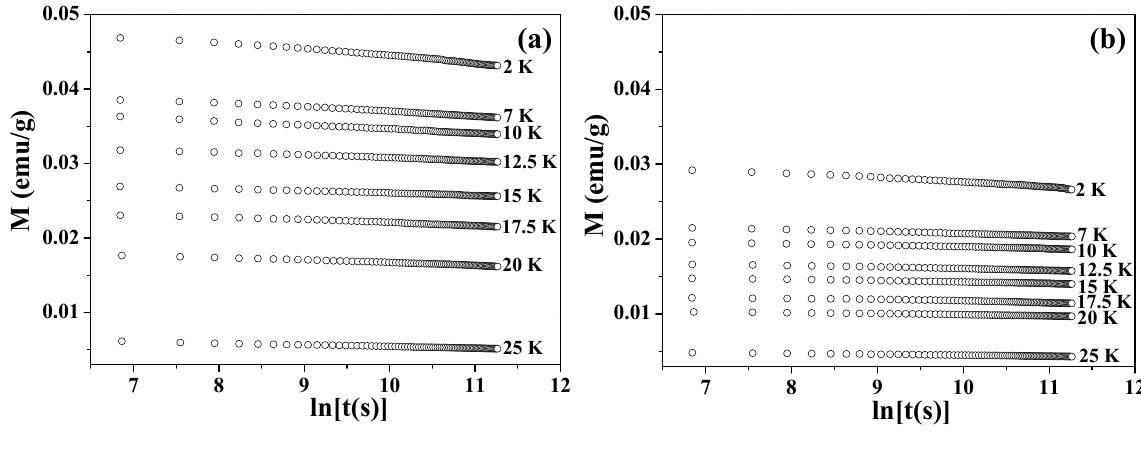
Figure 4. Time dependence of the magnetization ( M vs. ln t ) at 2–25 K for Co spheres of (a) 360 nm and (b) 680 nm.